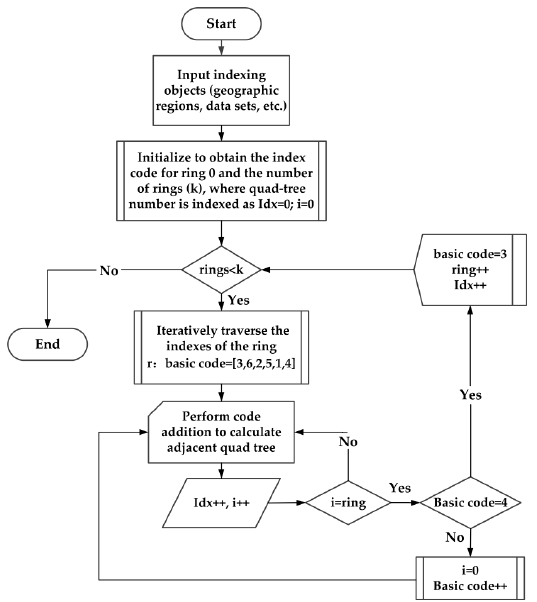
Figure 7. Process diagram of a single-level code indexing algorithm.